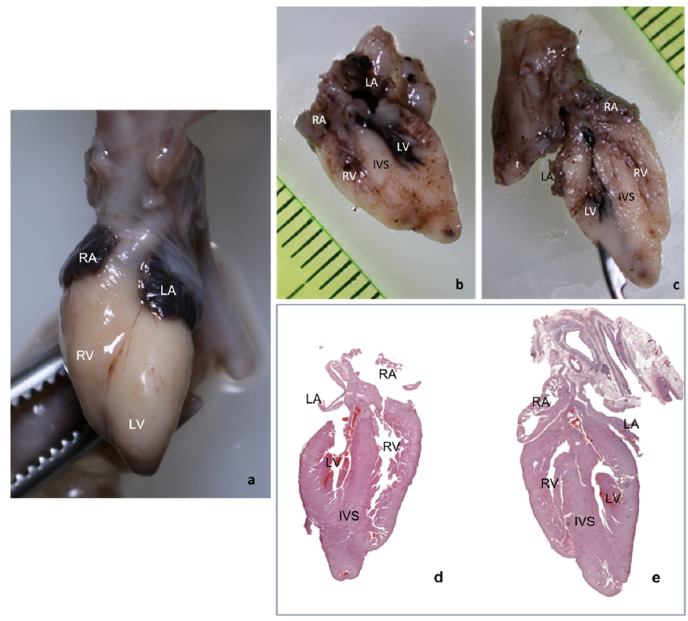
Figure 3. Mirrored view of microscopic slides as compared to macroscopy. ( a ) Macroscopic anterior view; ( b , c ) macroscopic inferior section; and ( d , e ) microscopic panoramic view, intermediate section.